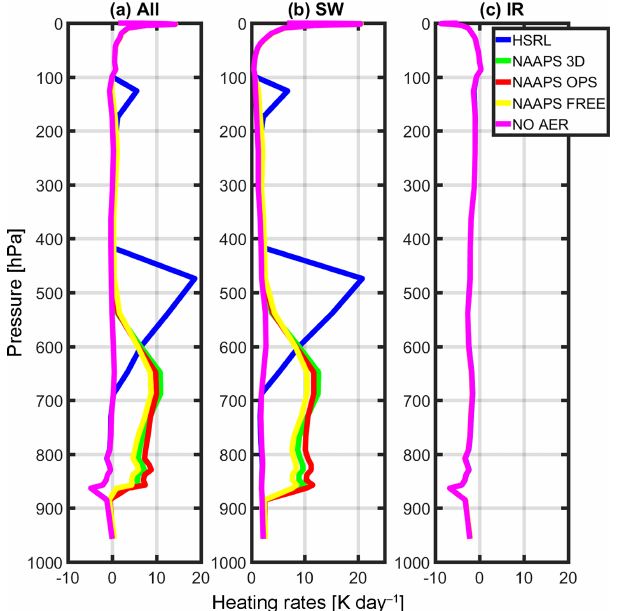
Figure 7. Instantaneous heating rates (IHR) for (a) the net, (b) SW Total , and (c) IR using MAIAC 555µm (BRF = 0.5152).